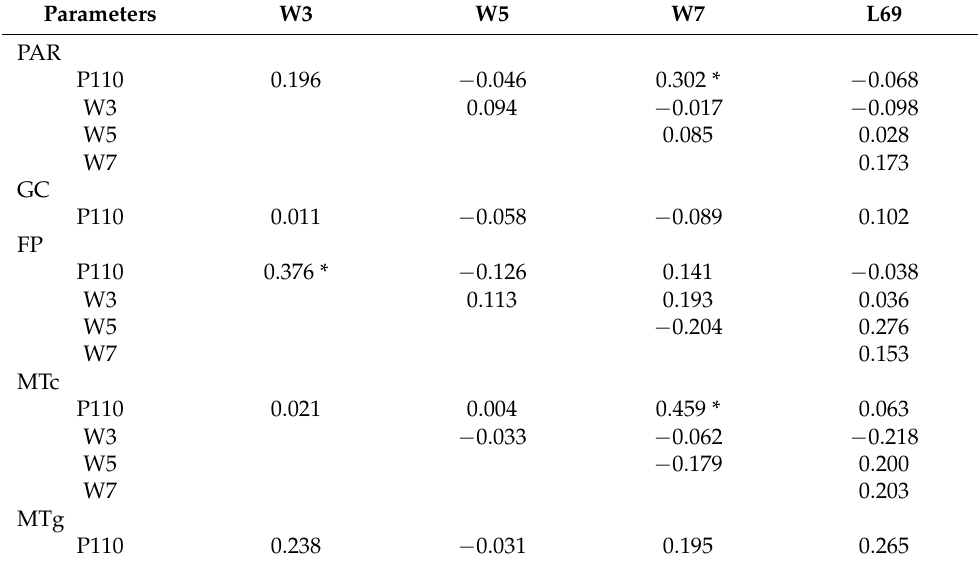
Table A1. Correlation coefficients of residuals of depths of the mammary parenchyma (PAR), fat pad (FP) and total depth of mammary gland conservative (MTc) per udder half in pregnancy